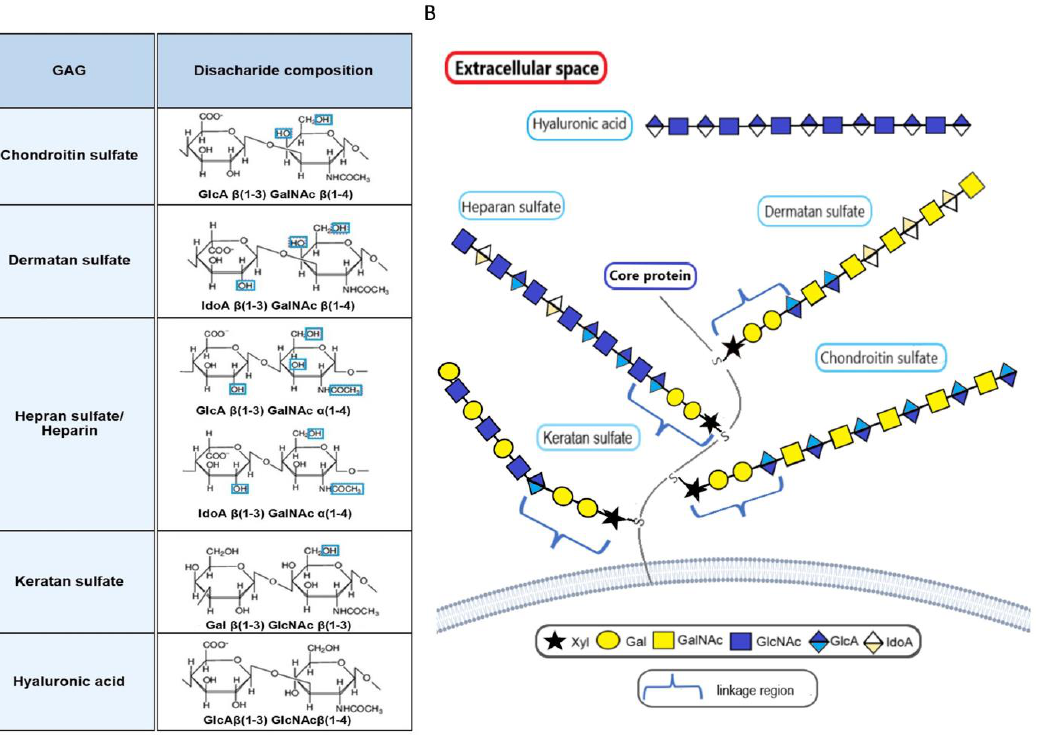
Figure 7. Disacharide composition of GAGs. Heparan sulfate, chondroitin sulfate, keratan sulfate, and dermatan sulfate have a common tetrasaccharide linkage region consisting of xylose (Xyl), two galactose (Gal) residues, and single glucuronic acid (GlcA). Hyaluronic acid consists of alternately appearing N-acetyloglucosamine (GlcNAc) and iduronic acid (IdoA). The figure presents chemical structures of GAGs ( A ) and their schematic visualization ( B ).